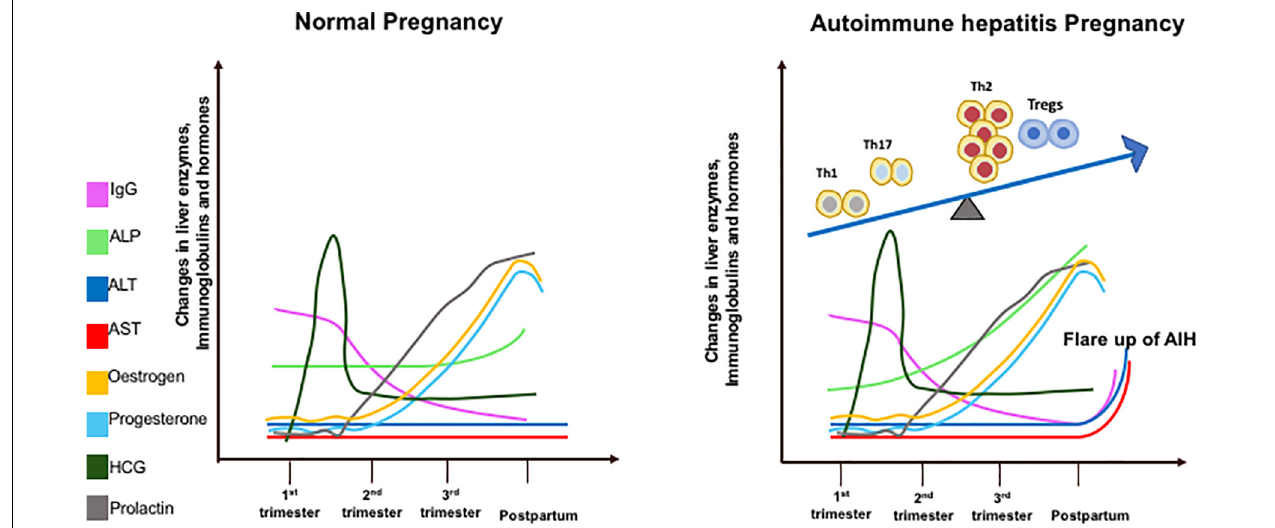
FIGURE 1 | Diagrammatic illustration of liver enzymes (aspartate transaminase – AST; alanine transaminase – ALT; alkaline phosphatase – ALP), Immunoglobulin G, and hormone changes during pregnancy in healthy and AIH pregnant women. These changes are correlated with T helper (Th1/Th2/Th17) regulatory T cells (Tregs) immune cell subsets during pregnancy in AIH women (right